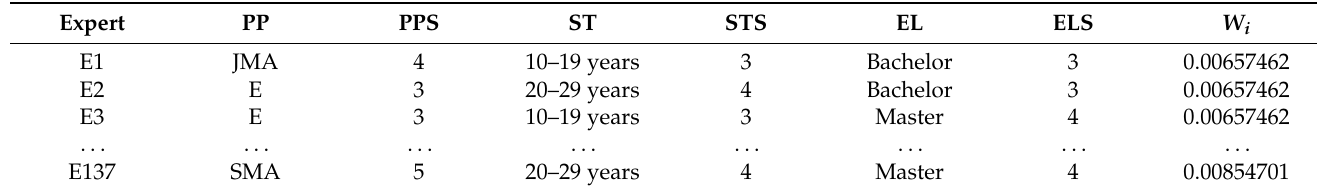
Table 6. Selective information of the experts and the associate weights.